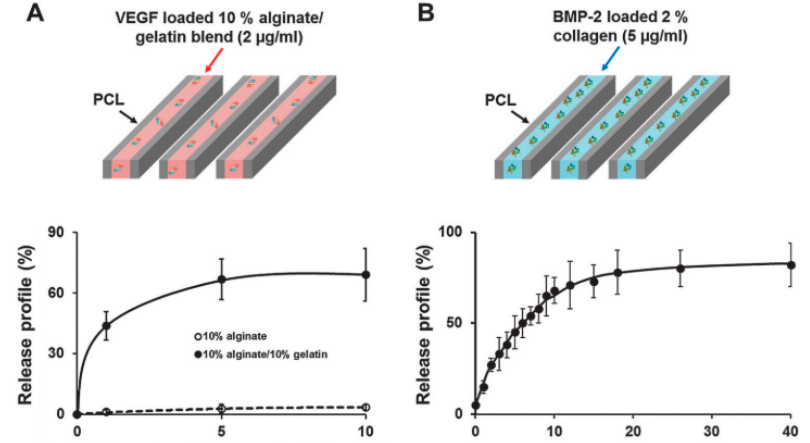
Figure 4. Release profile of: VEGF-loaded alginate / gelatin bioink ( A ); and BMP-2-loaded collagen hydrogel in PCL 3D printed construct ( B ). Reprinted from Reference [46]. Published by The Royal Society of Chemistry.